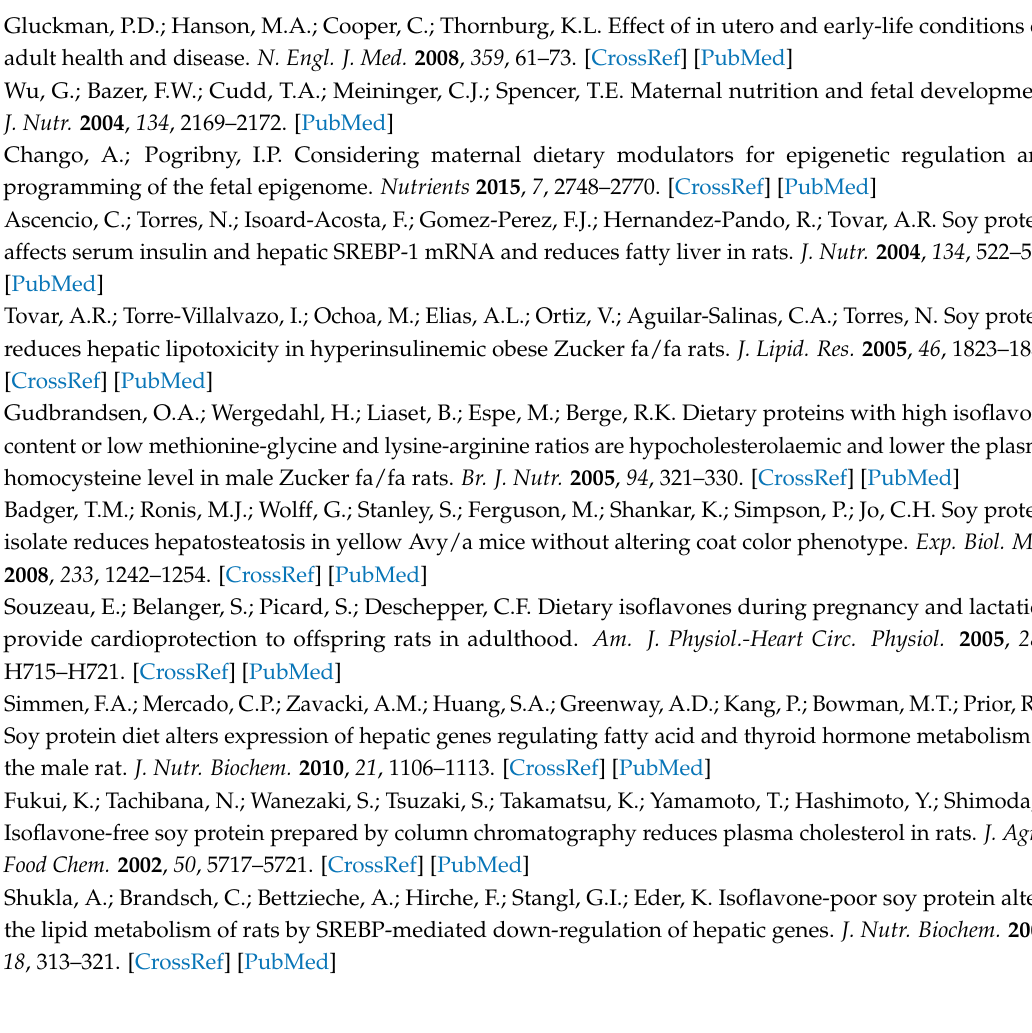
Table S1: List of primers used for real-time PCR (TaqMan); Table S2: Primer sequences for real-time PCR (SYBR green); Figure S1: Effects of diet on body weight of dams during pre-pregnancy, pregnancy and lactation. Data are means ± standard effort of the mean ( n = 6–9). Means with different superscripts are significantly different at p < 0.05. CAS-D, dams fed a casein diet; SPI-D, dams fed a low-isoflavone soy protein isolate diet; GEN-D, dams fed a casein plus genistein diet; Figure S2: Effects of maternal diet on hepatic gene expression related to lipid metabolism of male offspring. Each column of heat map represents the mean of the individual differentially expressed genes in maternal diet group ( n = 4). Data were Z-score normalized. Yellow color represents the up-regulated gene expression compared to the mean, whereas blue color represents the down-regulated gene expression below the